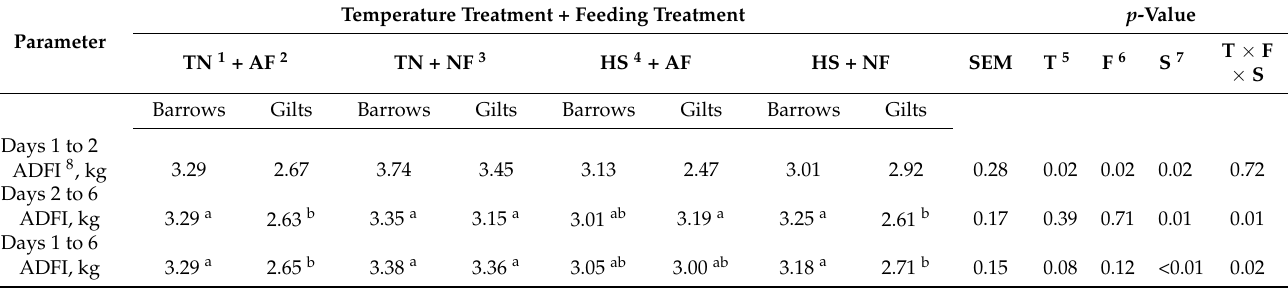
Table 4. Effects of temperature and feeding treatments ( TF ) and sex on average daily feed intake, monitored on Days 1 to 2, Days 2 to 6, and Days 1 to 6 of the post-TF period in finishing pigs.